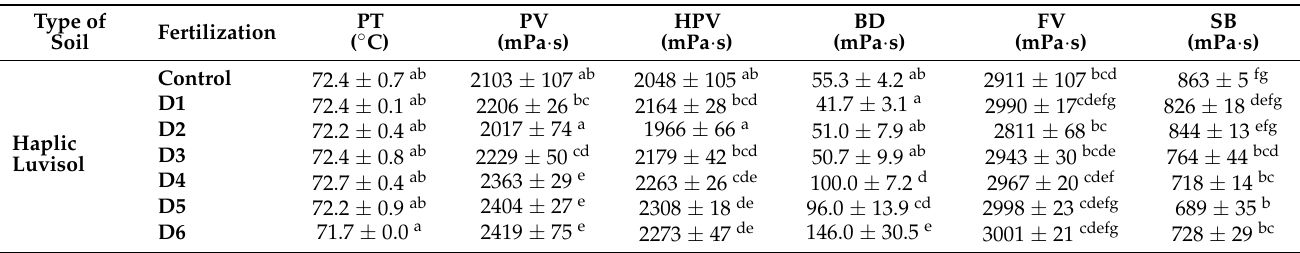
Table 4. Pasting characteristics of potato